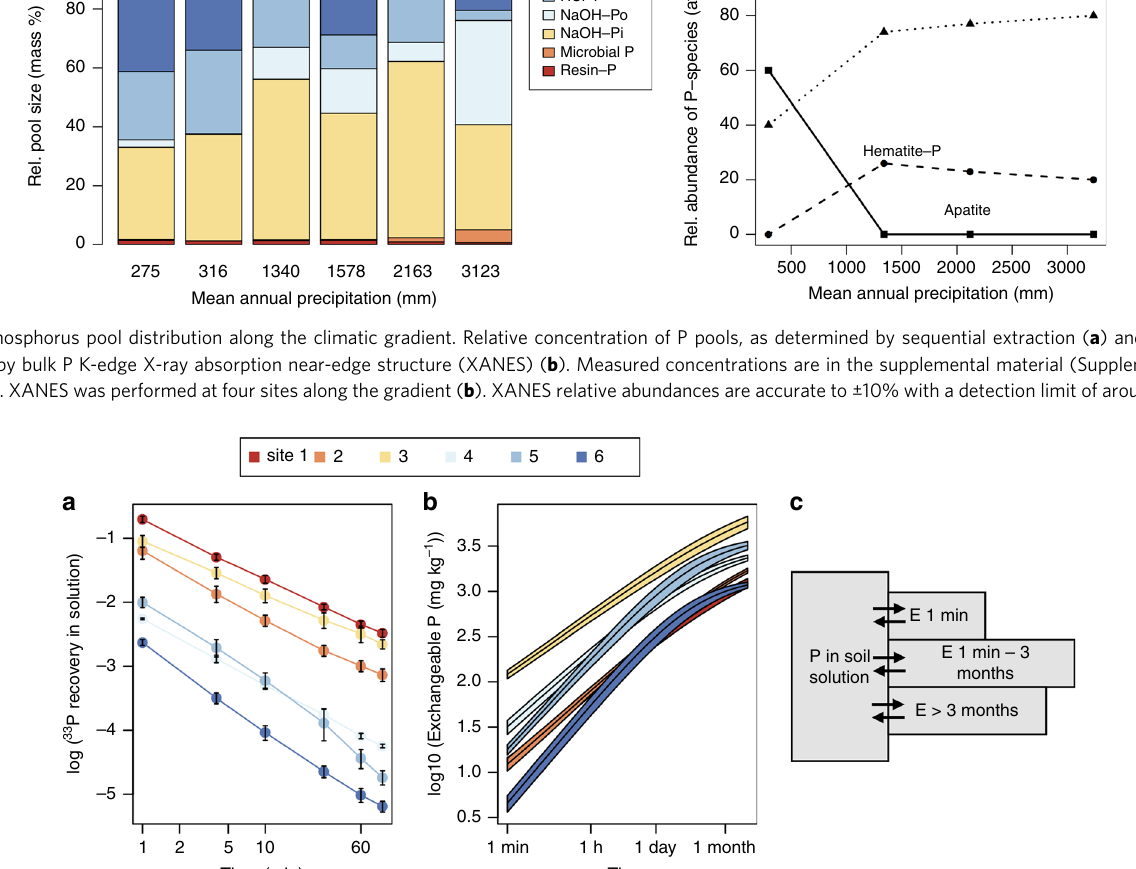
´ R P w is the concentration of P in the soil solution ( b ). Error ranges r t ðÞ , where w